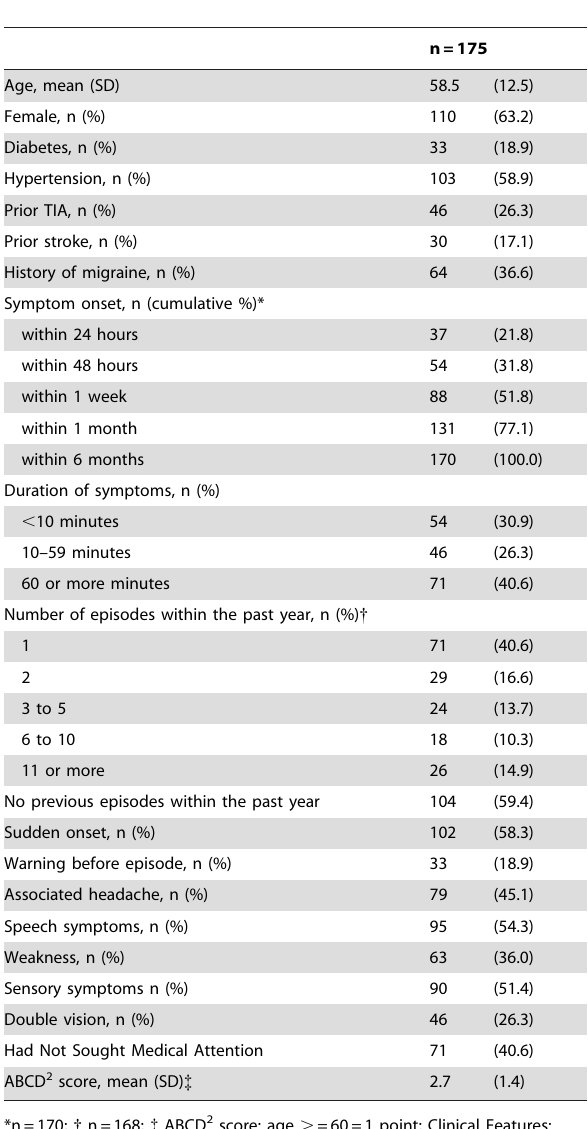
Table 1. Characteristics of 175 users seeking information on Transient Ischemic Attack or Mini-Stroke